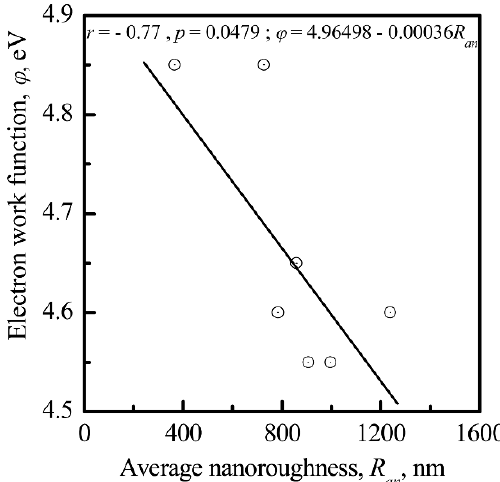
Figure 13. The dependence of the electron work function ( φ ) on the average nanoroughness ( R an ) of the CP coating.